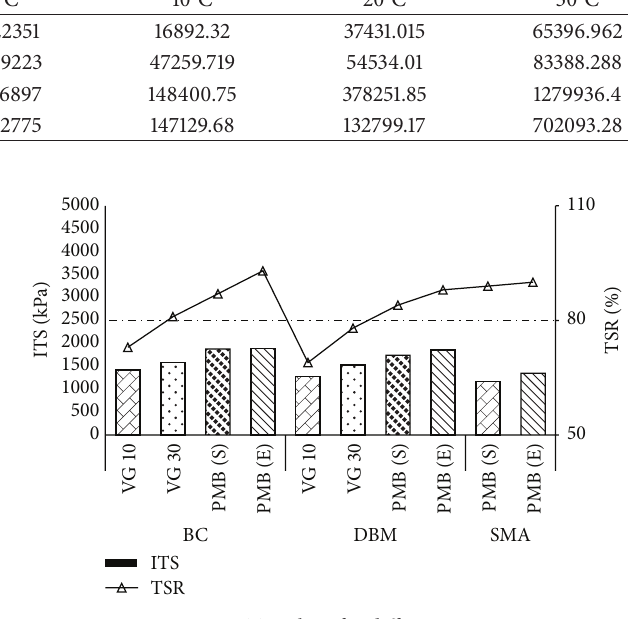
Figure 5: ITS values for different mixes.